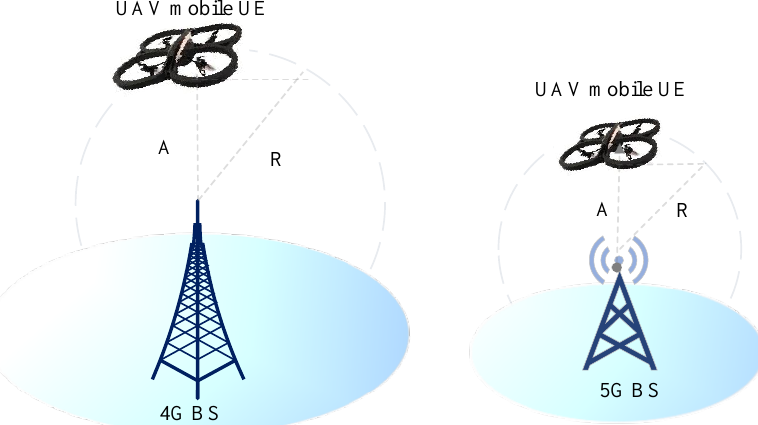
Figure 6. UAV–based station coverage according to altitude. Equations (1) and (2) describe how to produce the A and R , as shown in the illustration.